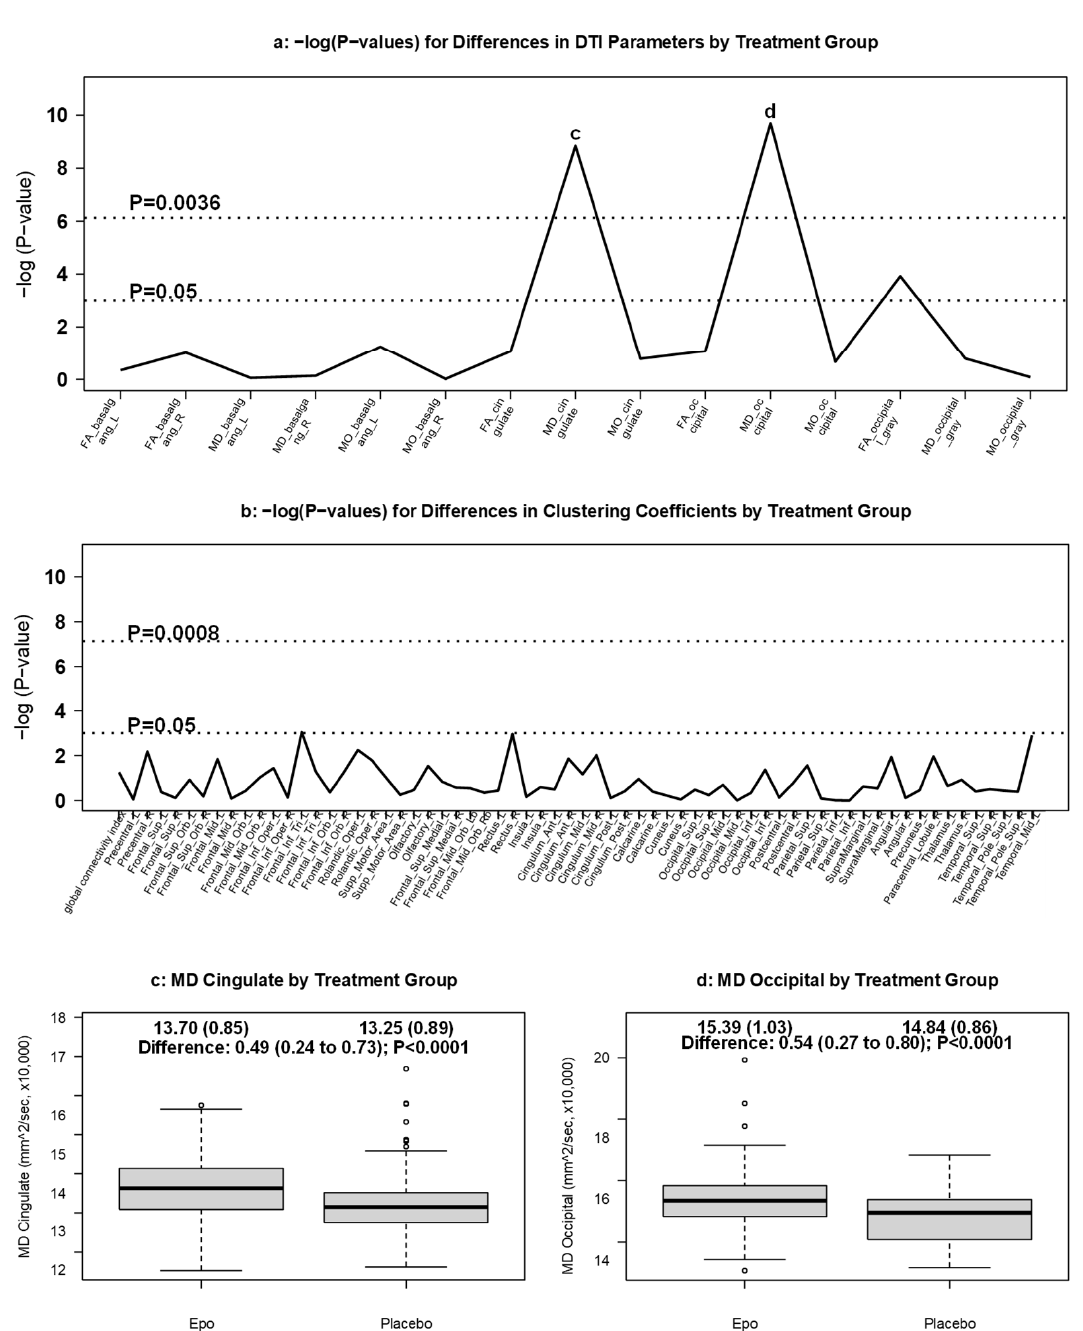
Figure 3. DTI measures by treatment group. Manhattan plot of [GEE-based Wald test] -log ( p -values) for differences in ( a ) regional DTI diffusion values and ( b ) clustering coefficients by treatment group. Panels ( c , d ) display boxplots of ROIs with MD values found to be significantly different in the cingulate and occipital white matter ROIs, respectively, by treatment group.